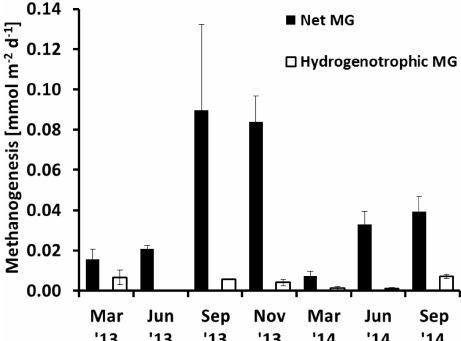
Figure 5. Integrated net methanogenesis (MG) rates (determined by net methane production) and hydrogenotrophic MG rates (de- termined by radiotracer incubation) in the surface sediments (0– 25cmb.s.f.) of Eckernförde Bay for different sampled time points.